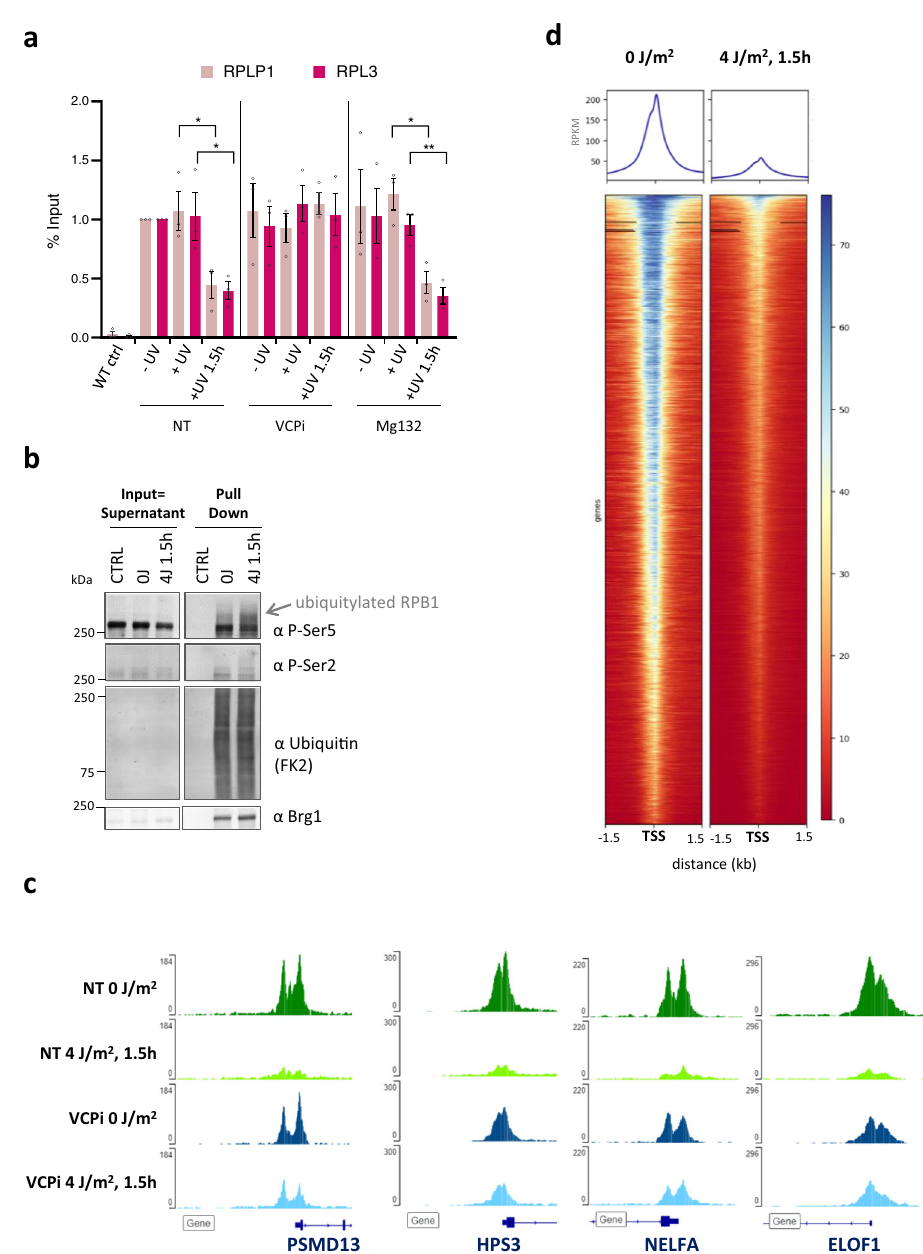
Fig. 3 P-Ser5-modi fi ed, promoter-bound Pol II is ubiquitylated, extracted by VCP and subsequently degraded. a Pol II promoter occupancy on the RPLP1 and RPL3 genes in GFP-RPB1 KI cells after the indicated treatments determined by GFP ChIP followed by q-PCR. Wild-type cells without GFP-RPB1 were analysed as negative control (WT Ctrl). VCPi = VCP inhibitor (NMS-873, 5 µ M 30 min before UV irradiation), Mg132 = proteasome inhibitor (10 µ M, 30 min before UV irradiation). Average Pol II occupancy around the transcription start site of n = 3 independent experiments is shown, error bars indicate SE. All conditions were normalized to promoter occupancy in nonperturbed conditions (NT -UV), which was set to 1. * P ≤ 0.05, ** P ≤ 0.01, ns nonsigni fi cant; analyzed by ordinary one-way ANOVA using Dunnett ’ s multiple comparisons test. b Isolation of ubiquitylated proteins using tandem ubiquitin-binding entities (TUBEs) from the supernatant of GFP-RPB1 KI cells after cellular fractionation. Cellular fractionation was optimized to separate hyper-phosphorylated, elongating Pol IIo in the pellet from hypo-phosphorylated, free and promoter-bound Pol IIa in the supernatant. Isolated ubiquitylated proteins were stained for promoter-paused Pol II (P-Ser5) and ubiquitin (FK2). FK2 staining con fi rms equal puri fi cation of ubiquitylated proteins. Brg1 staining was used as loading control. Note that ubiquitylated, P-Ser5 Pol II (pull-down) migrates higher compared to P-Ser5 Pol II in the input due to increased molecular weight. P-Ser = phospho-serine. The experiment has been performed two times with similar results. c , d Pol II occupancy around the transcription start site was analysed by Pol II ChIP-seq before and 1 h after 4 J/m 2 UV, and with or without VCP inhibition before UV irradiation. Pol II signal at representative individual genes ( c ), and heatmaps of Pol II on all refseq genes before and 1 h after 4 J/m 2 UV ( d ). Values were normalized to spike in controls. Heat maps are colour-scaled according to read densities form low (red) to high (blue) in units of